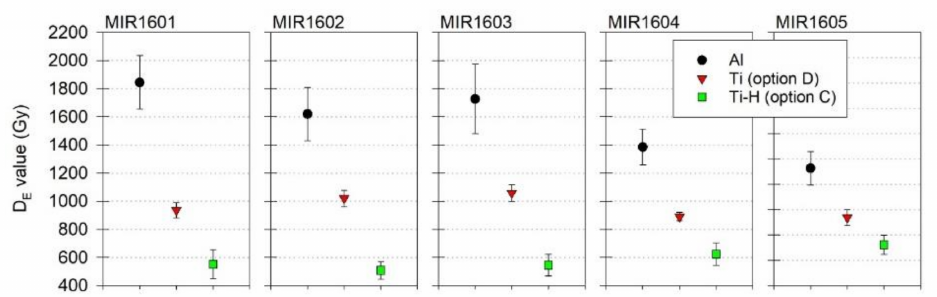
Figure 6. Multiple center approach. Comparison of D E results derived from measurements of Al and Ti